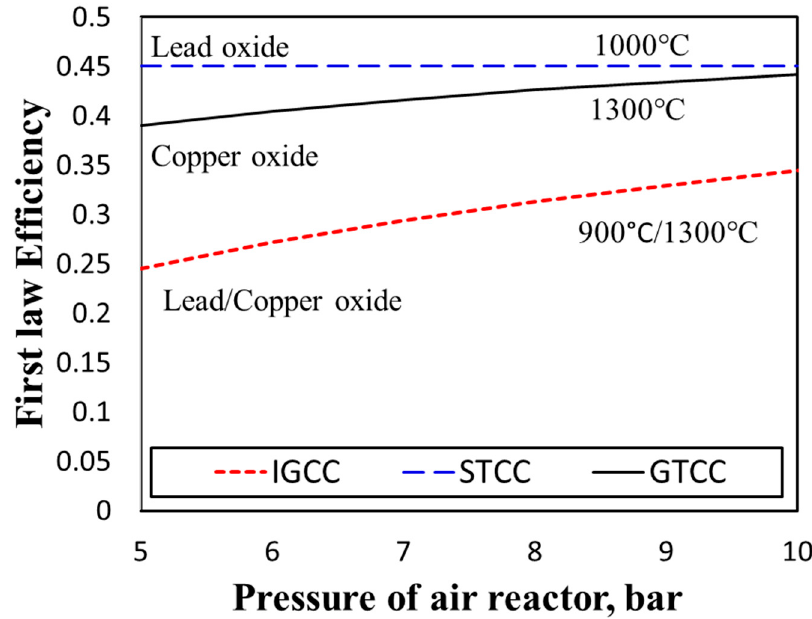
Figure 8. Dependence of FLE on the pressure of the air reactor.